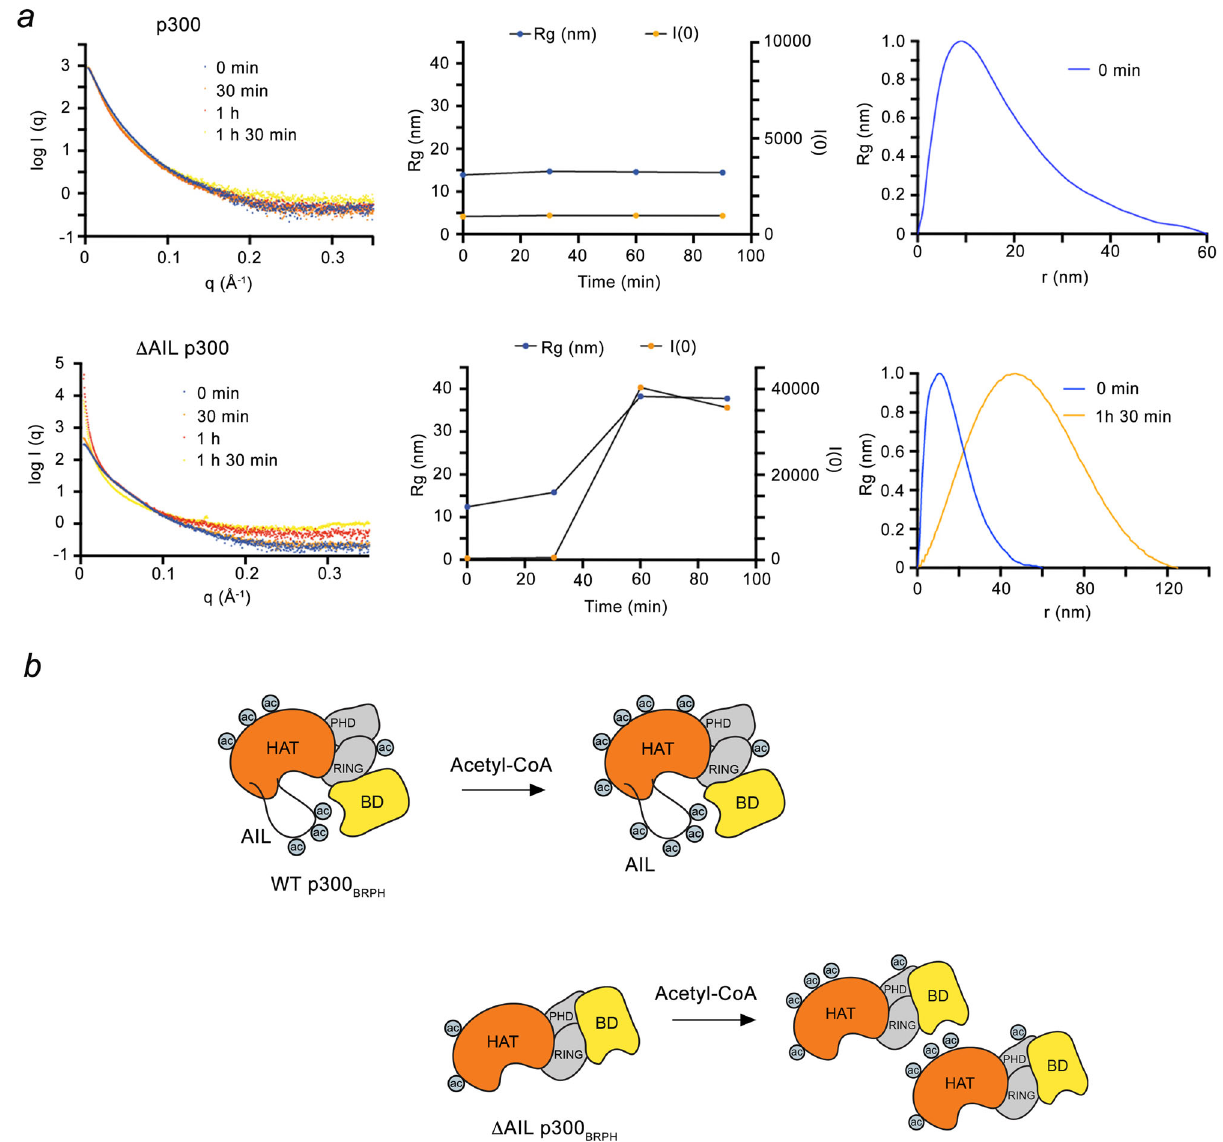
Fig. 5 Δ AIL p300 340 – 2094 interacts ‘ in trans ’ in solution. a Small angle X-ray scattering (SAXS) data collected for WT (upper panel) and Δ AIL (lower panel) p300 340 – 2094 upon addition of acetyl-CoA at indicated time points including 0 min (blue) and 90 min (orange). SAXS intensity (left), Rg plots (middle), and P ( r ) functions (right) determined from the experimental scattering data were shown. b Schematics of the WT and Δ AIL p300 BRPH intramolecular and intermolecular interactions between BD and acetylated